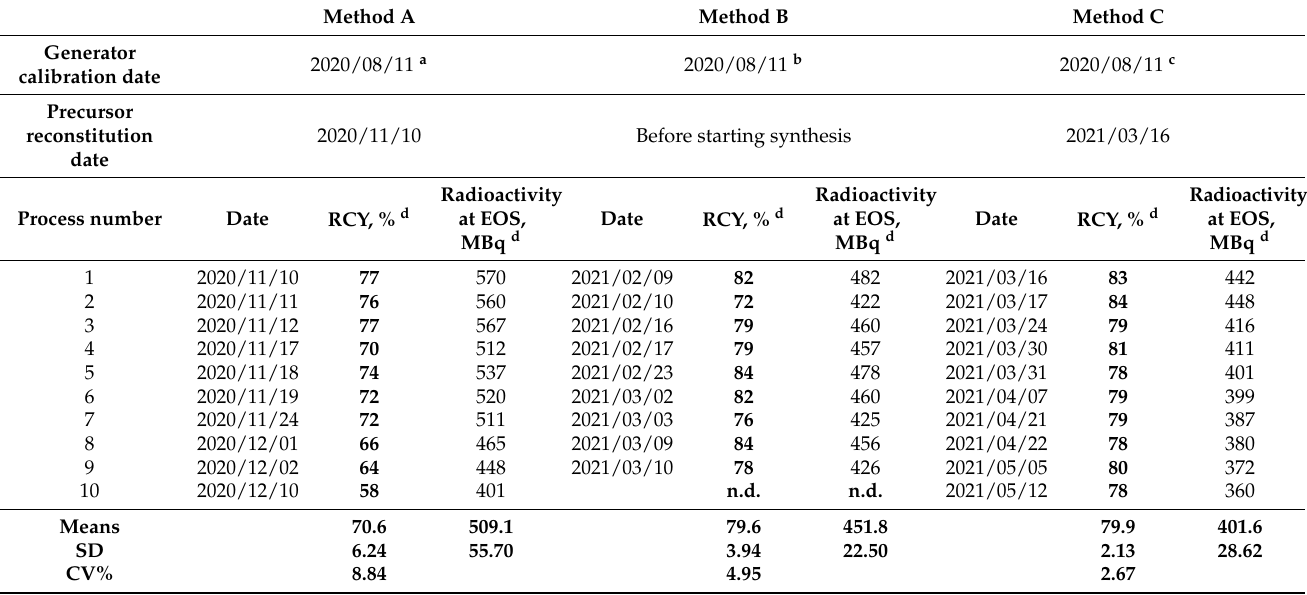
Table 1. Comparison of [ 68 Ga]Ga-PSMA-11 synthesis data from three